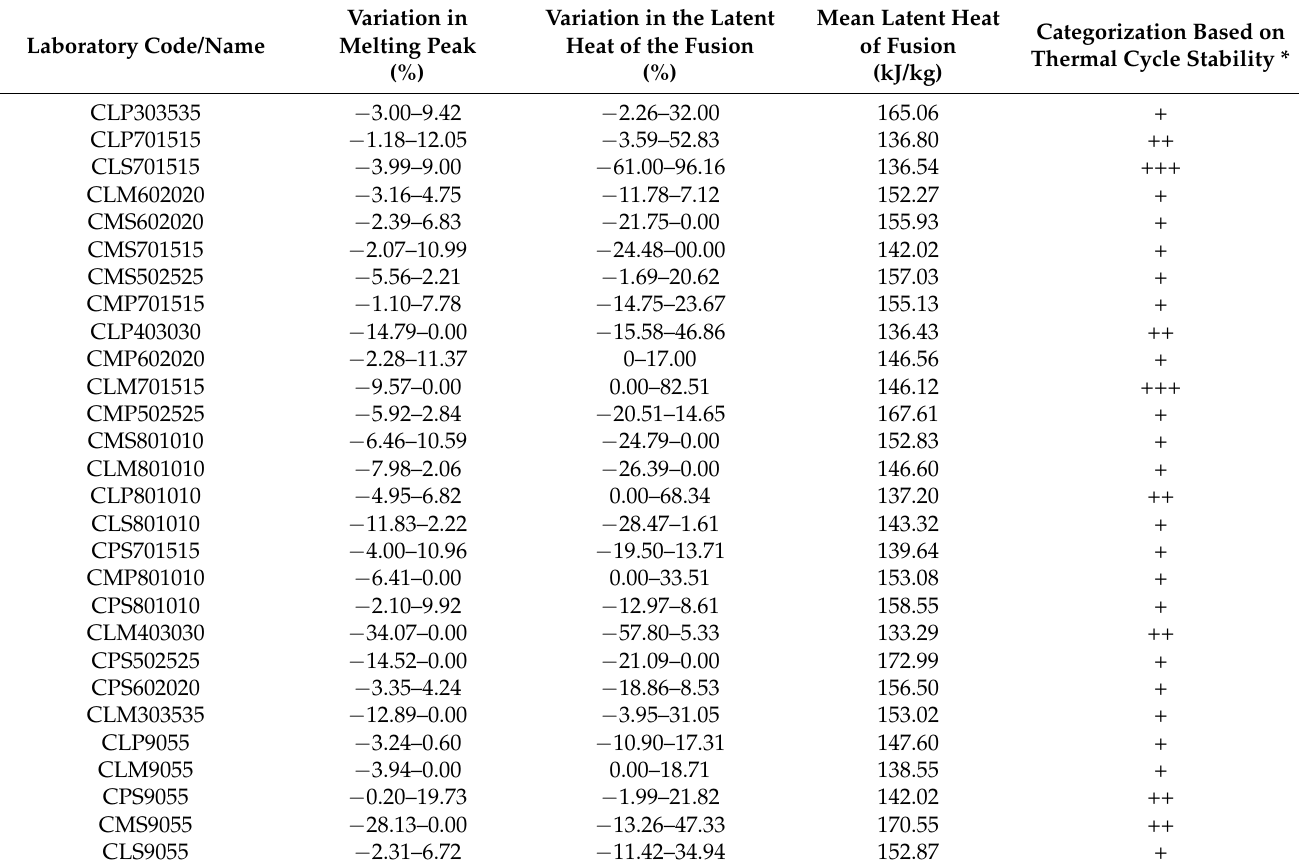
Table 14. Overall variation in melting temperature with the average latent heat of fusion.